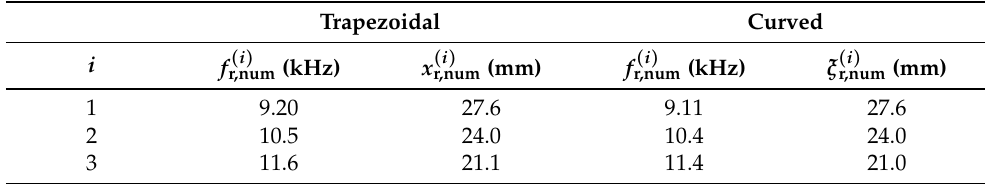
Table 1. Natural frequencies f and curved membrane devices based on the numerical analysis. The maximum deviation of f between the trapezoidal and curved membrane devices is 1.75% and that between x is 0.476%. Therefore, it is possible to conclude that these results are quantitatively consistent.